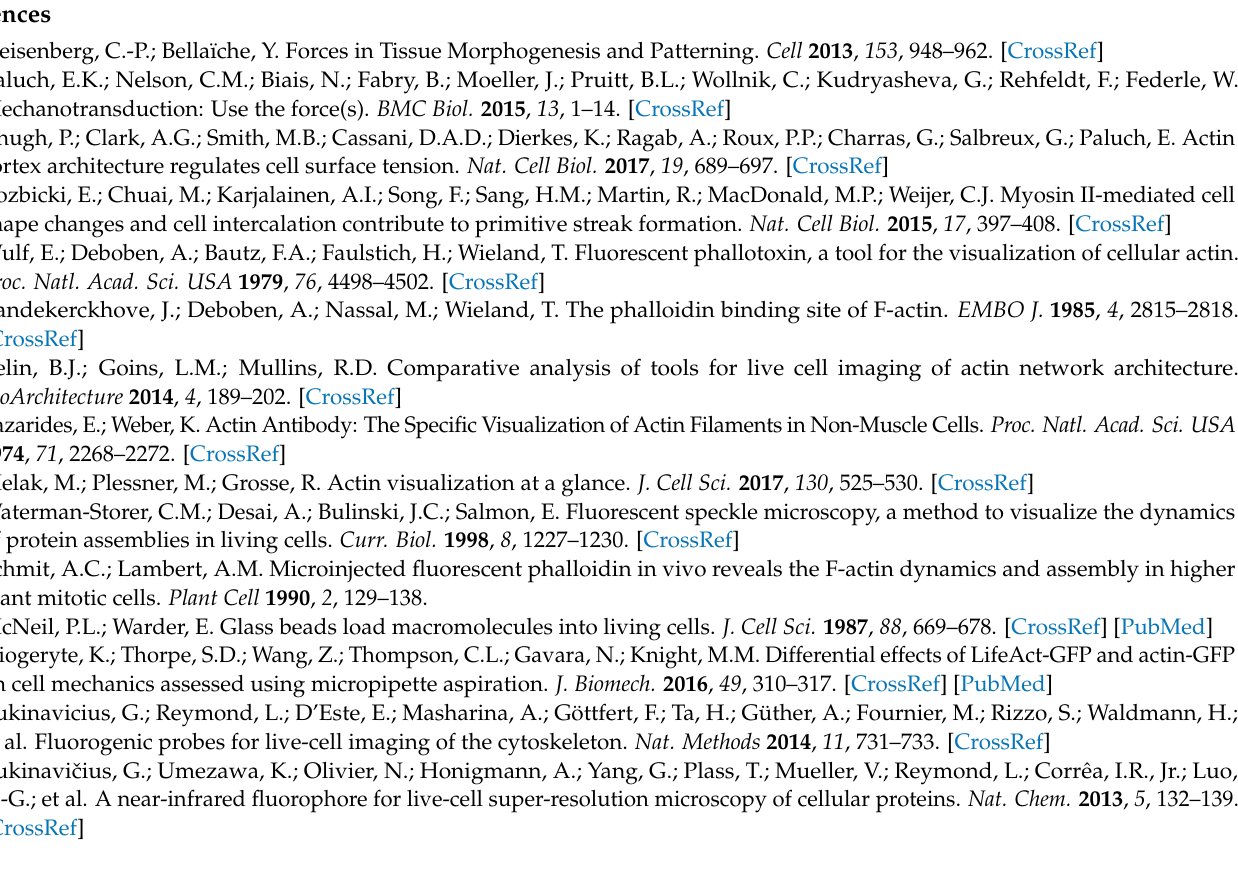
SP5, Table S2: Microscope settings Leica SP5, Table S3: Average somite formation time, Figure S1: Numerical aperture Zeiss PlanNeofluar 1.0 × objective, Figure S2: Embryonic development and gradual increase of SiR-actin